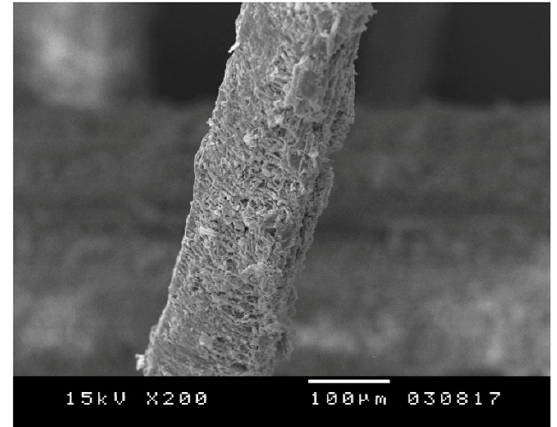
Figure 3. SEM image of crushed Juncus maritimus fibers.